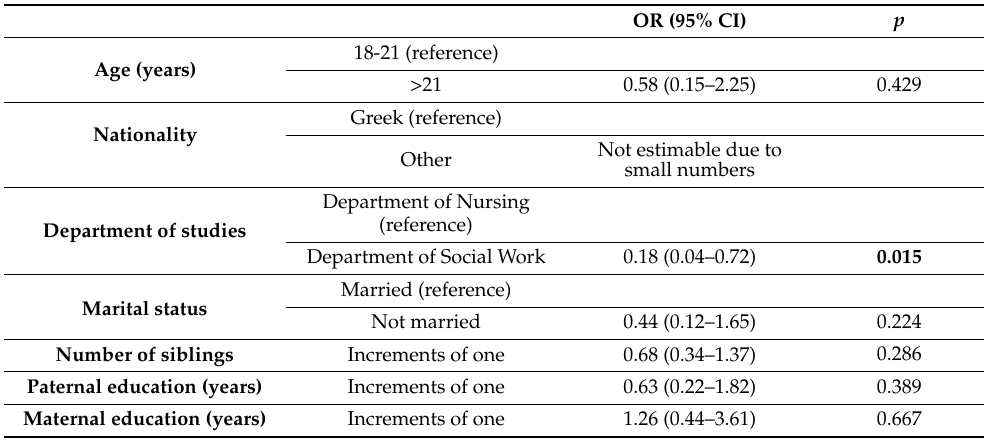
Table 8. Multivariate logistic regression analysis of having a Pap smear test in association with so- ciodemographic features; this analysis was confined to female students. Bold cells denote statistically significant